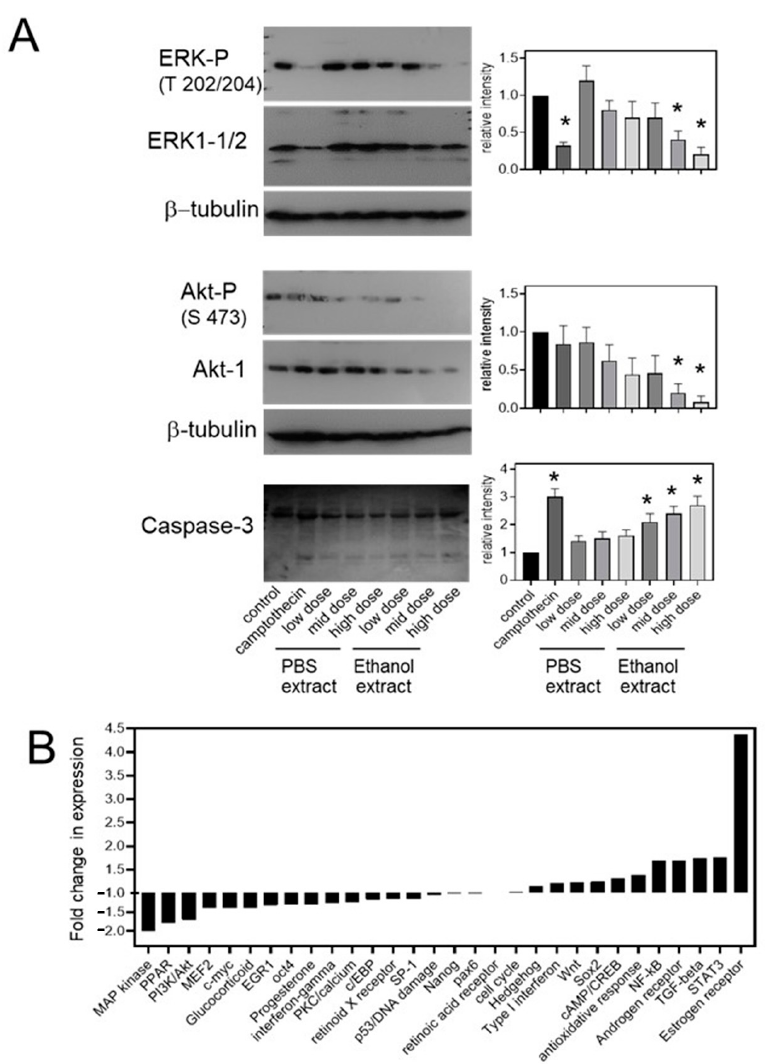
Figure 4. Treatment with Uncaria tomentosa inhibits ERK and Akt phosphorylation and promotes caspase cleavage in B16-BL6 cells: ( A ) B16-BL6 cells were treated with ethanol or PBS extracts of Uncaria tomentosa or 10 − 6 M Camptothecin for 48 h and cell lysates were collected and subjected to immunoblot analysis using ERK (threonine 202/204) phosphate, ERK1/2, Akt (serine 473) phosphate, Akt, β -tubulin, and caspase-3 antibodies. The relative intensities of the phosphorylated bands, normalized for the level of total protein or the relative level of cleaved/uncleaved forms, were determined by densitometry and the fold change for 3 independent experiments, as shown in the bar graphs. Differences compared to the control were considered significant (*) when p ≤ 0.05 by a Tukey post hoc test; ( B ) the relative activity of the indicated transcription factor pathways for B16-BL6 cells treated with 100 µ g/mL of the ethanol extract of Uncaria tomentosa for 24 h was determined using the Cignal transcriptional profile assay. The relative luminescence was corrected for a constitutive control plasmid and fold changes between the Uncaria- and vehicle only-treated controls are reported for two